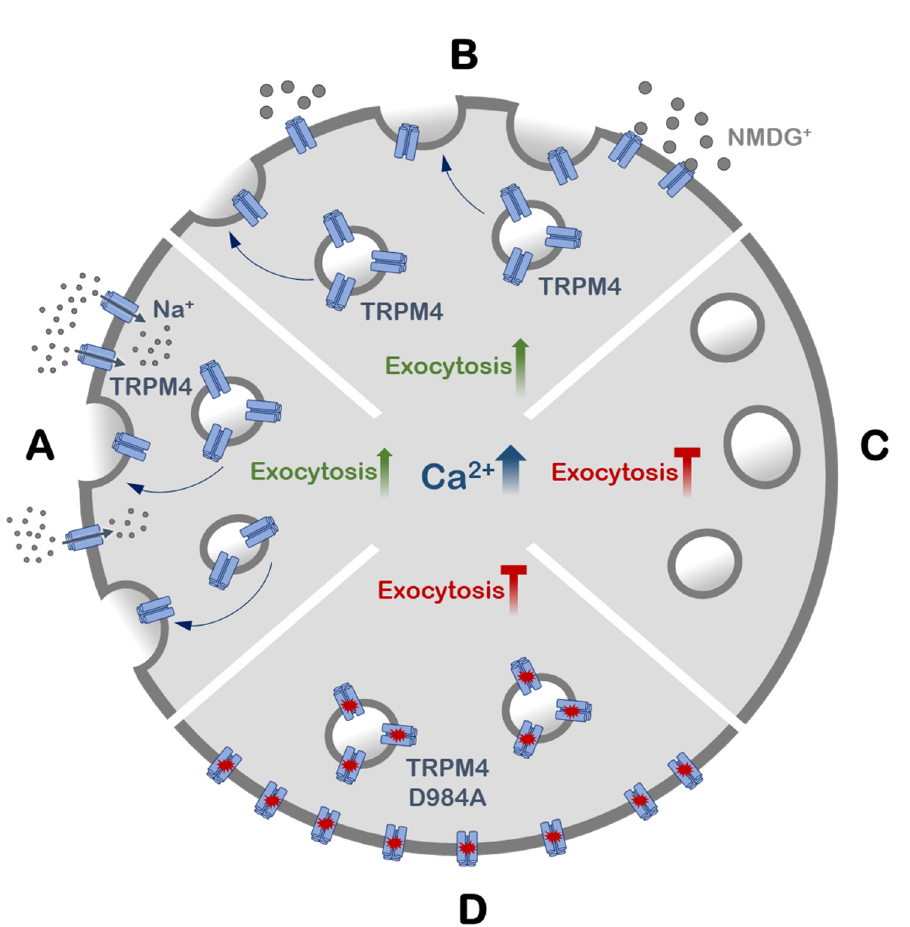
Figure 7. Graphical representation of the main findings. ( A ) An increase in intracellular Ca 2+ triggers the exocytosis of TRPM4-containing vesicles. ( B ) Ca 2+- induced exocytosis is independent of plasma membrane TRPM4. ( C ) Exocytosis is inhibited when TRPM4 is absent. ( D ) Exocytosis is inhibited when non-functional TRPM4 is expressed .